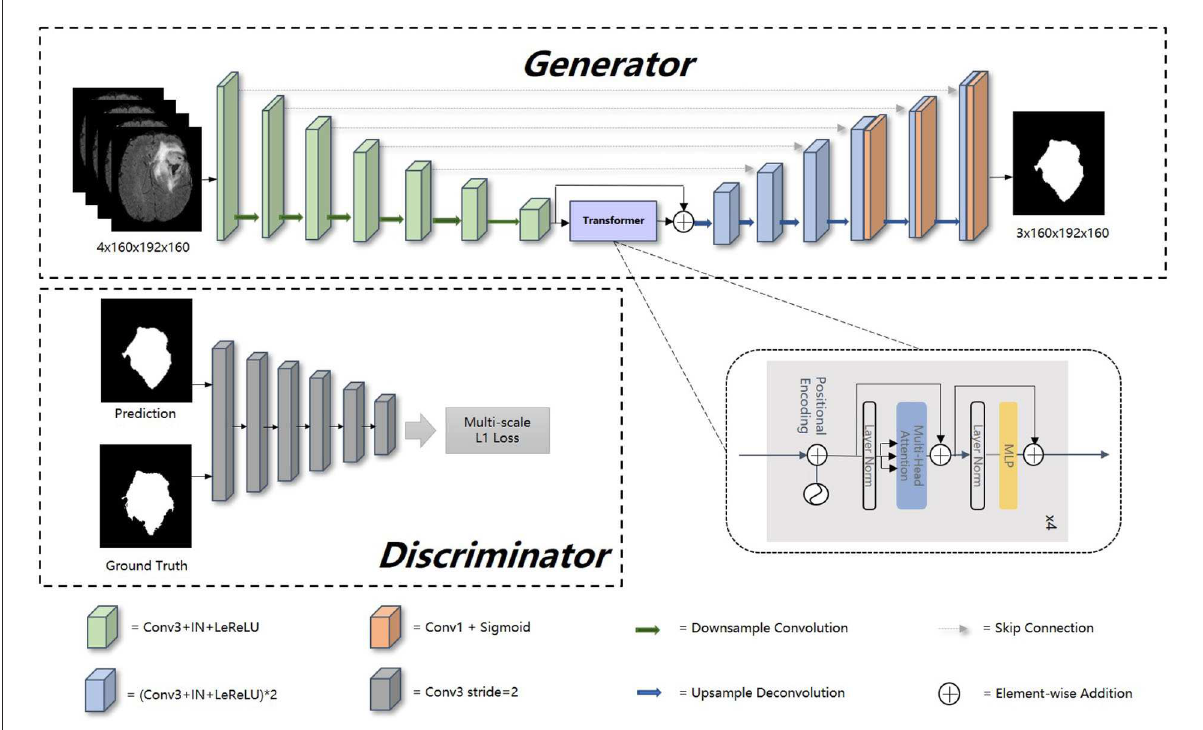
FIGURE1 Overall architecture of our proposed method. In this figure, “Conv1” represents convolutional layer with kernel 1 3 3 3, “IN” represents InstanceNorm layer, “LeReLU” means LeakyReLU activation × ×